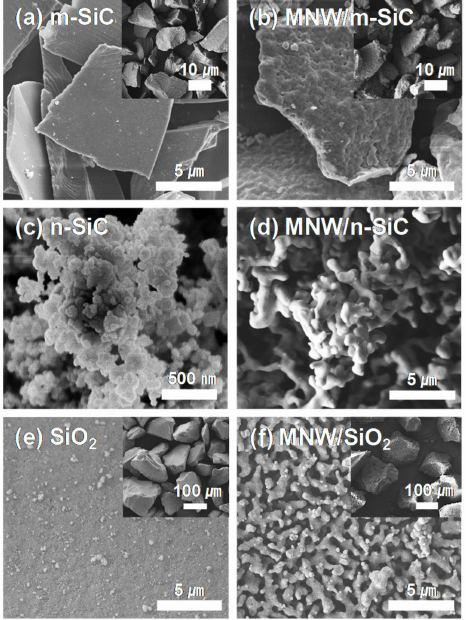
Figure 3. The scanning electron microscope (SEM) images of pristine supports and supported Mn 2 O 3 -Na 2 WO 4 catalysts: ( a ) m-SiC; ( b ) MNW / m-SiC; ( c ) n-SiC; ( d ) MNW / n-SiC, ( e ) SiO 2 ; and ( f ) MNW / SiO 2